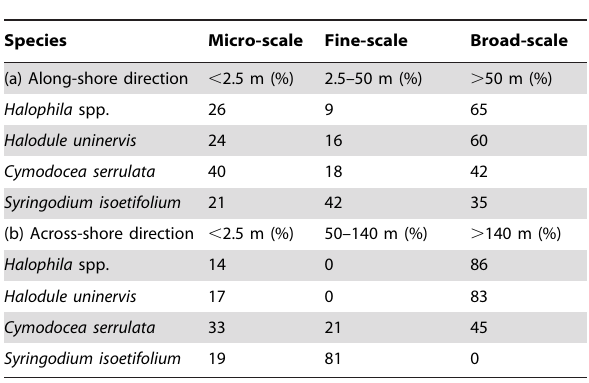
Table 4. Percent of total variance for each species explained at each spatial scale, fitted to the constraints of the Linear Model of Coregionalization in the (a) along-shore, and (b) across-shore.